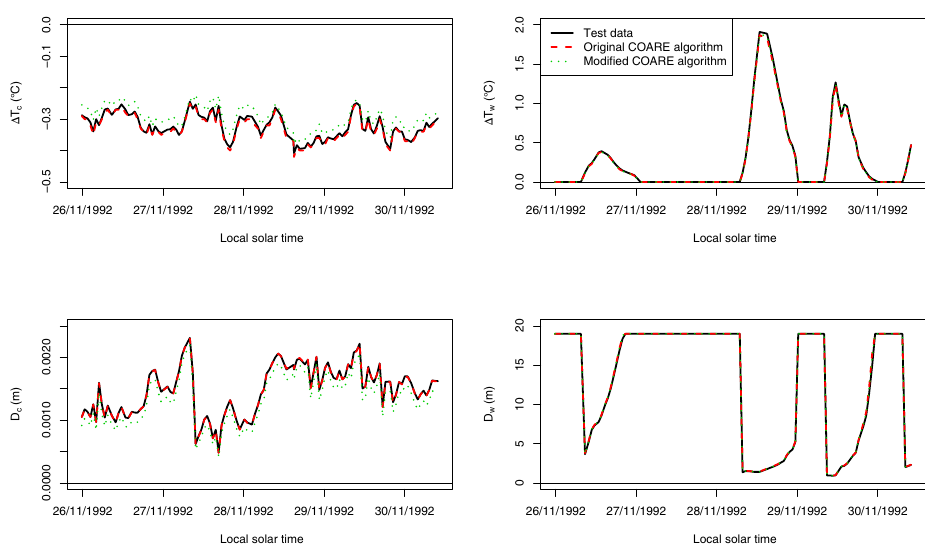
Figure 2. Validation of the implementation of bulk flux COARE algorithm and its modification: cool skin effect ( (cid:49)T c ), cool skin depth ( D c ), warm layer effect ( (cid:49)T w ) and warm layer depth ( D w ). Data are 4 days of Moana Wave COARE test